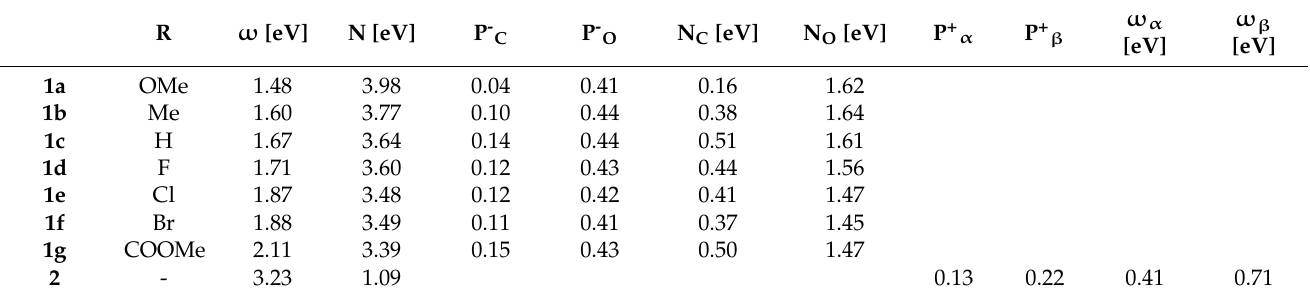
Table 1. Global and local electronic properties of diarylnitrones 1a–g and TBMN 2 .